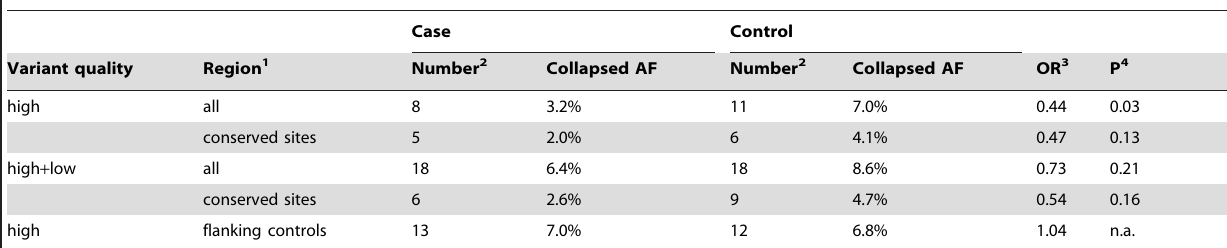
Table 3. Rare SNVs found in candidate regions.